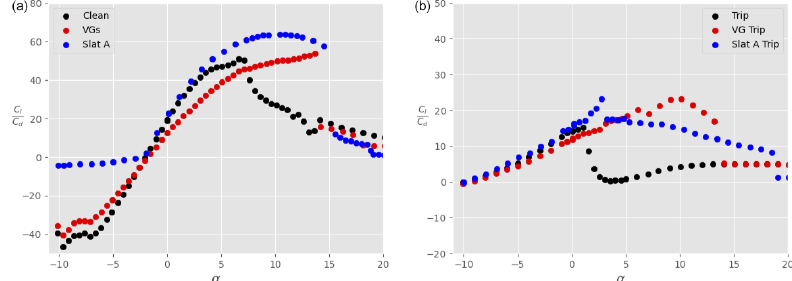
Figure 19. Lift-to-drag ratio C l /C d as a function of the angle of attack α for the main airfoil at Re = 1 . 5 × 10 6 , without VGs and without slat (black), with VGs only (red), and with slat only in configuration A (blue). (a) Clean airfoil; (b) tripped airfoil.